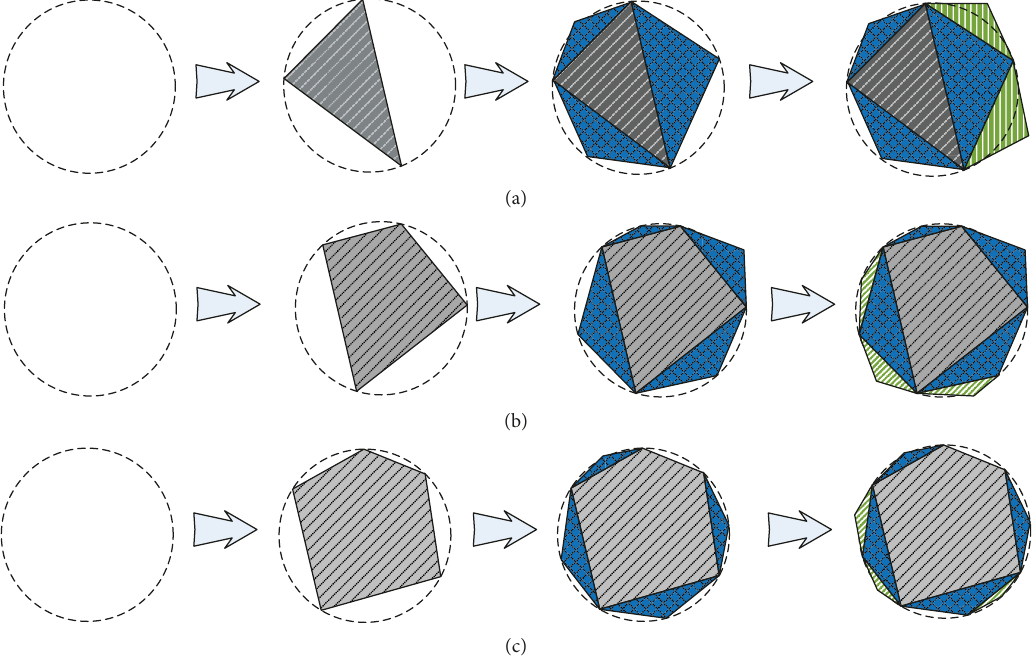
Figure 3: Convex polygon aggregate generation pattern.